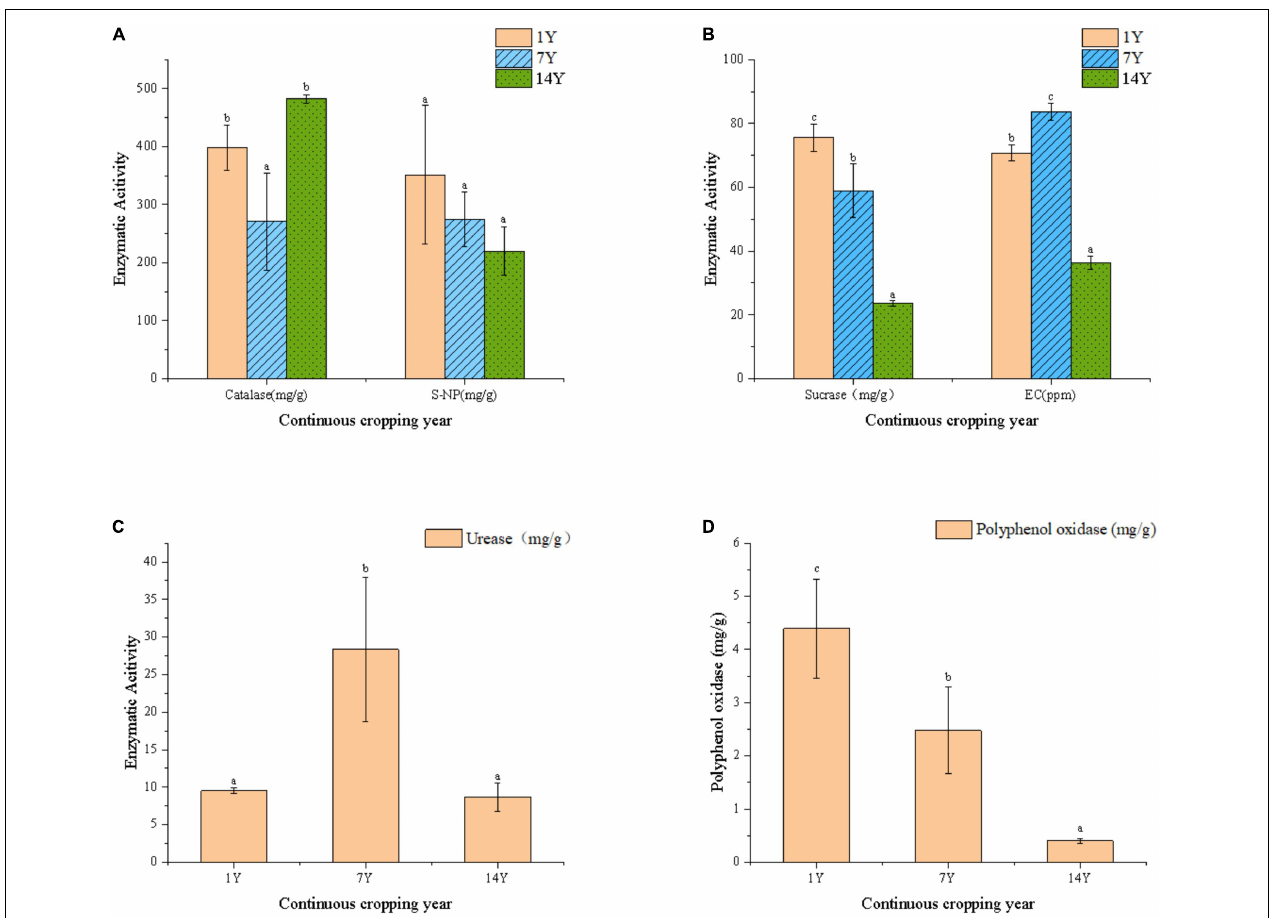
FIGURE 1 | Changes of enzyme activity, electrical conduction and organic matter content m rhizosphere soils from fields with continuous cropping of alfalfa for 1, 7, and 14 years. (A) Catalase and S-NP activity. (B) Sucrase activity and electrical conduction. (C) Urease activity. (D) Polyphenol oxidase activity. Error bars indicate standard errors of the means of three repetitions. Different letters above the bars indicate significant difference according to Duncan’s multiple range test ( P =